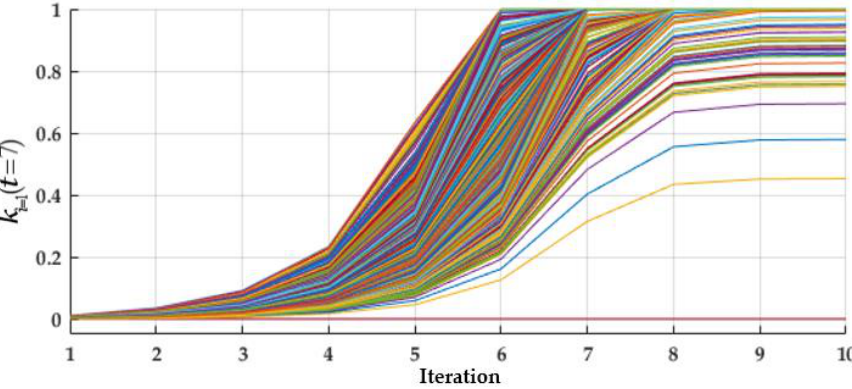
Figure 8. The dynamic process of the non-cooperative process for every customers’ ideal rebate ratio.